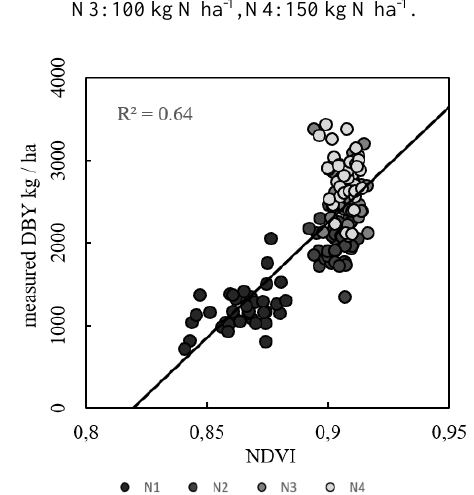
Figure 7. VNIR-based Normalized Difference Vegetation Index (NDVI) vs. dry biomass yield (DBY) . N1: 0 kg N ha -1 , N2: 50 kg N ha -1 , N3: 100 kg N ha -1 , N4: 150 kg N ha -1